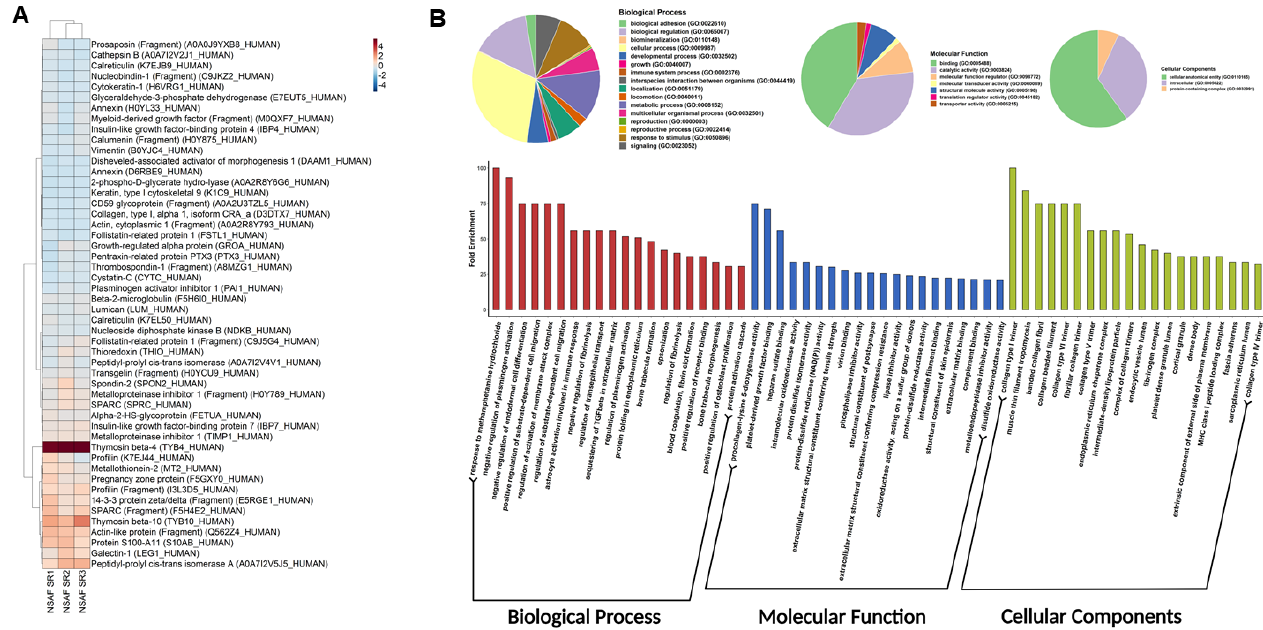
Figure 5. ( A ) Heatmap for the top 50 NSAF proteins for the three replicates. Clustered by Ward algorithm and scaled by each replicate. Associated scale represents scales values of NSAF metric. ( B ) Gene ontology analysis. The upper side (pie chart) of the figure shows the biological process, molecular function, and cellular component total protein percentage hits in each analysis. The bar plot shows the top 20 hits of enrichment biological process (red), molecular function (blue), and cellular component (yellow). Y axis represents enriched fold change.